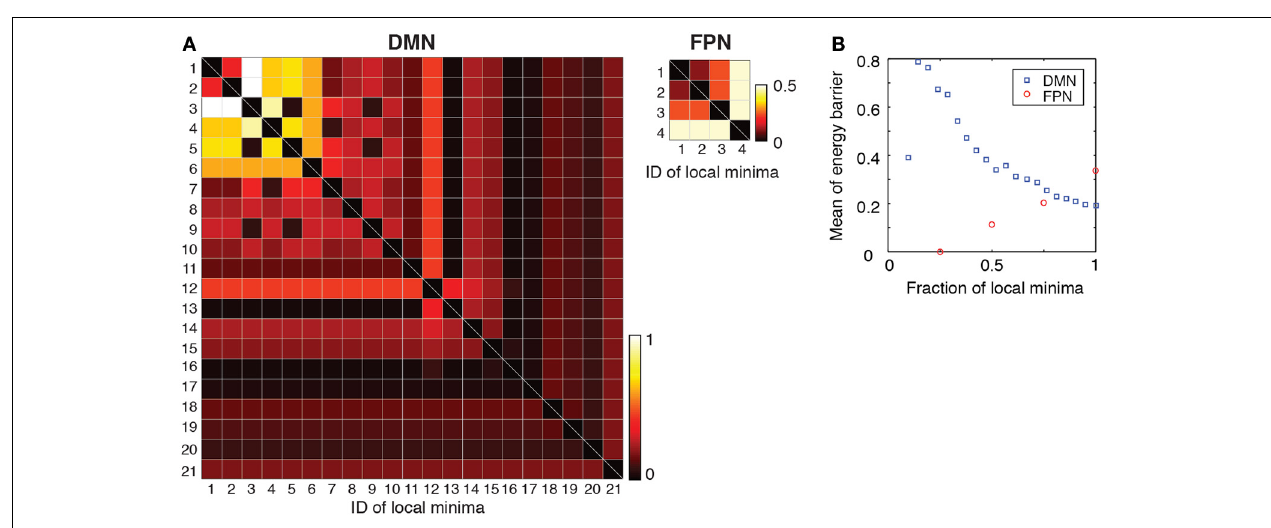
belong to the basin of one of the local minima with the lowest energies. This quantity is plotted against the fraction of local minima with the lowest energies. The solid and dashed curves indicate the results for the DMN and FPN, respectively.